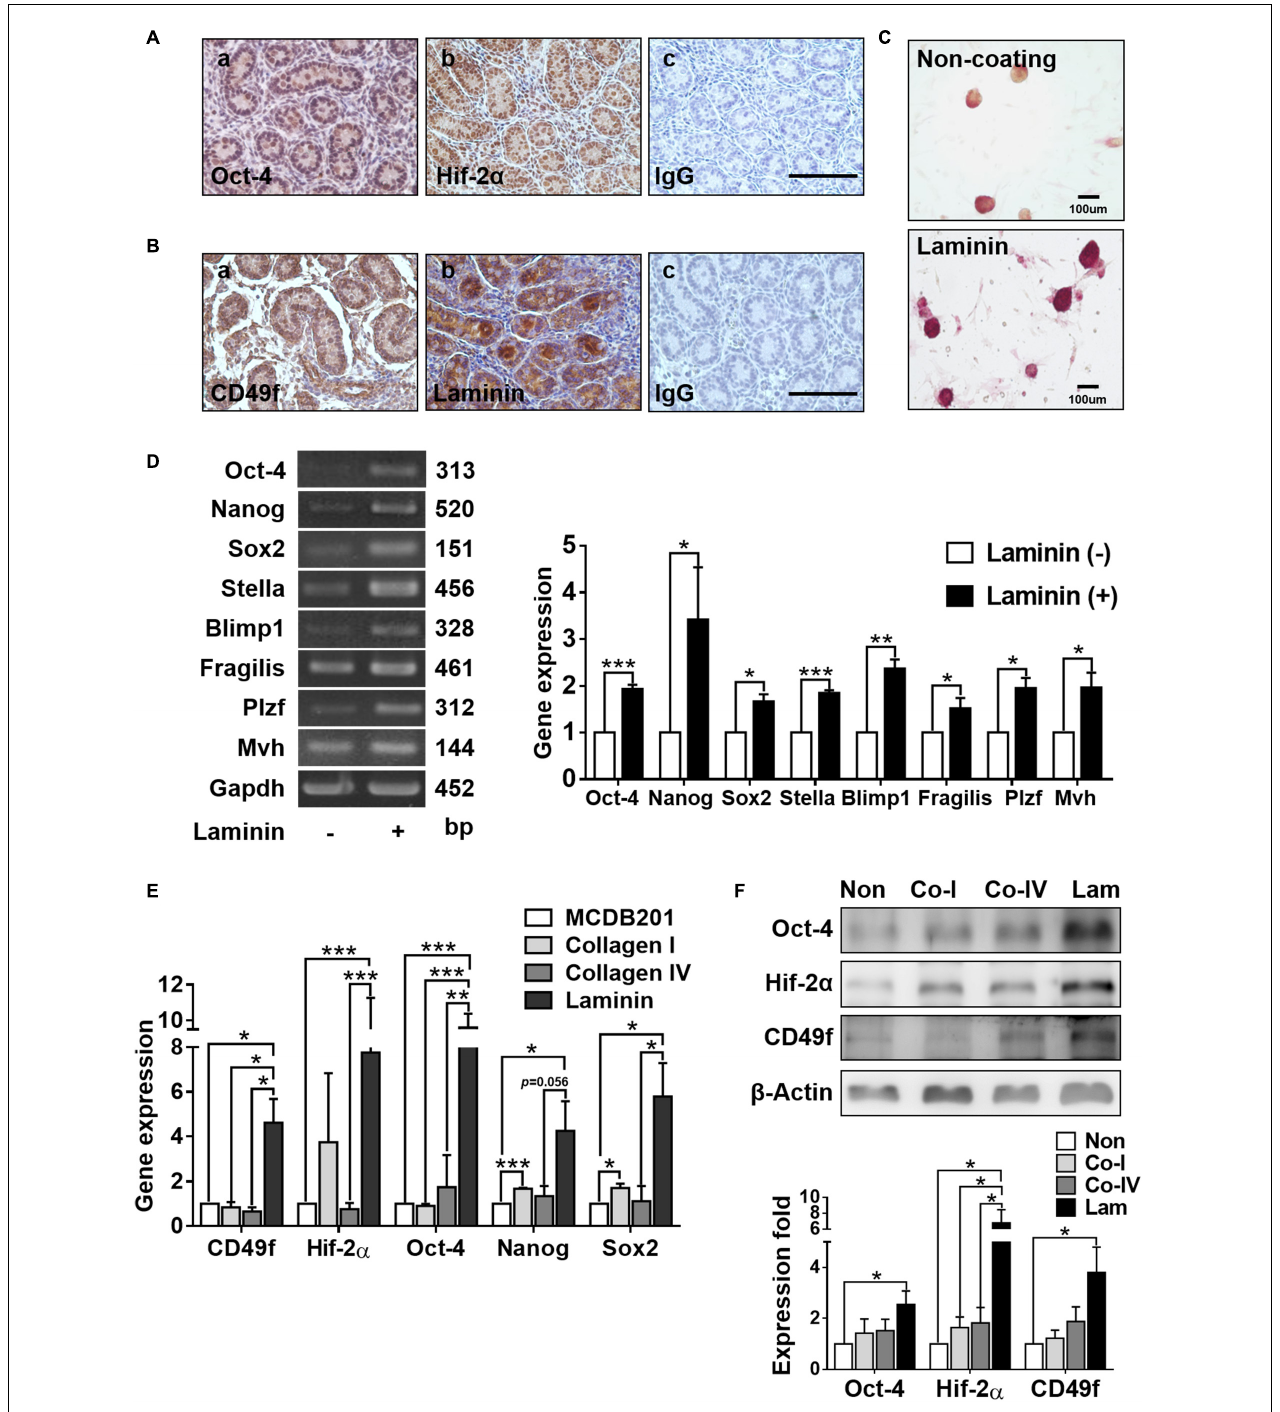
FIGURE 1 | Laminin increases alkaline phosphatase (AP) activity and stemness-related gene expression in mouse germline stem cells (GSCs) (AP + GSCs). (A,B) Protein expression and localization of Oct-4 (A-a) , Hif-2 α (A-b) , CD49f (B-a) , and laminin (B-b) in cells obtained from testes of 2 days postpartum mice. (A-c,B-c) Control. Bar = 100 µ m. (C) Stained alkaline phosphatase (AP) activity in GSC colonies cultivated on laminin-coated or non-coated culture plates. Bar = 100 µ m. (D) Gene expression in GSC colonies cultivated on laminin-coated or non-coated culture plates through reverse transcription polymerase chain reaction (RT-PCR) (left panel) and RT-qPCR (right panel) analyses. (E) Gene expression in magnetic-activated cell-sorting system (MACS)-purified CD49f + AP + GSCs cultivated on culture plates coated with different ECM components determined through RT-PCR analysis. (F) Protein expression in MACS-purified CD49f + AP + GSCs cultivated on culture plates coated with different ECM components through Western blot analysis. Lam: laminin. Co-I: type I collagen. Co-IV: type IV collagen. Statistical data are means ± SEM of at least three independent experiments for each condition. * p < 0.05; ** p < 0.01; *** p < 0.001 (Student’s t -test).